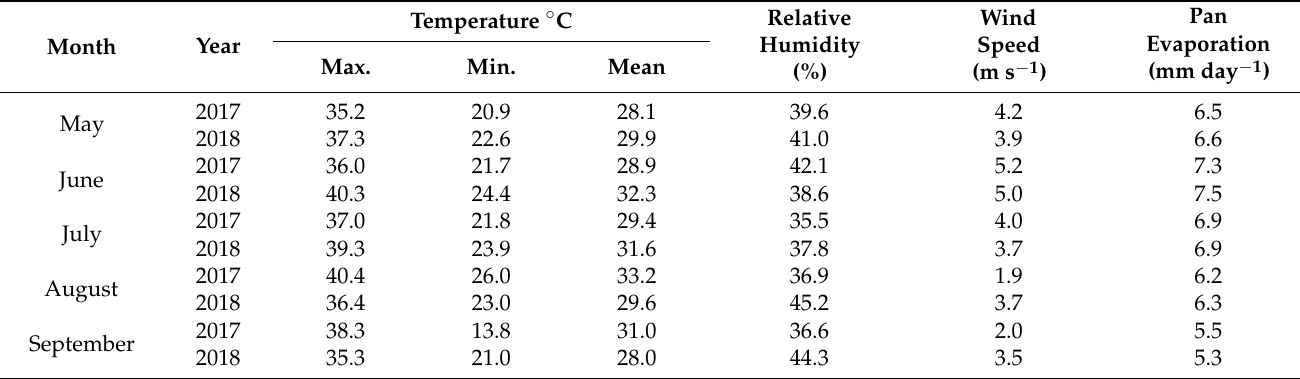
Table 1. Meteorological data recorded at Meteorological observatory of Fayoum governorate, during crop growing seasons of 2017 and 2018.